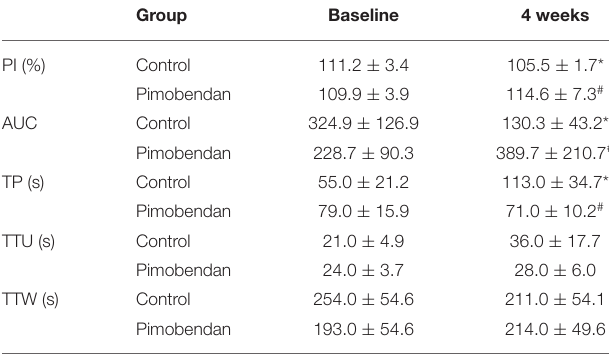
TABLE 3 | Values of parameters of the time-intensity change rate curve in the contrast-enhanced ultrasonography of the pancreas. Group Baseline 4 weeks